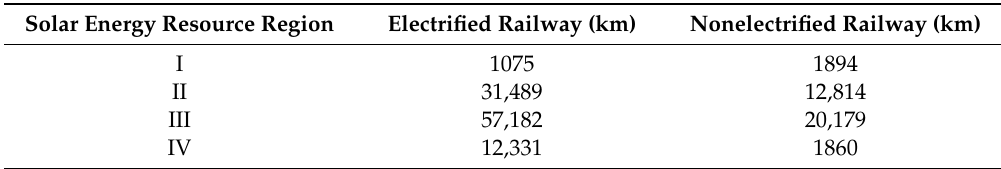
Figure 1. Cross-distribution layout of railway lines and solar energy resources in China: ( a ) electrified railway and ( b ) nonelectrified railway. Table 1. The length of electrified and nonelectrified railway lines in the four solar energy resource regions in China.